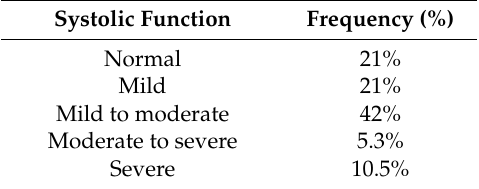
Table 2. Rating of systolic dysfunction severity in the patients measured by echocardiography. Systolic Function Frequency (%) Normal 21% Mild 21% Mild to moderate 42% Moderate to severe 5.3% Severe 10.5%